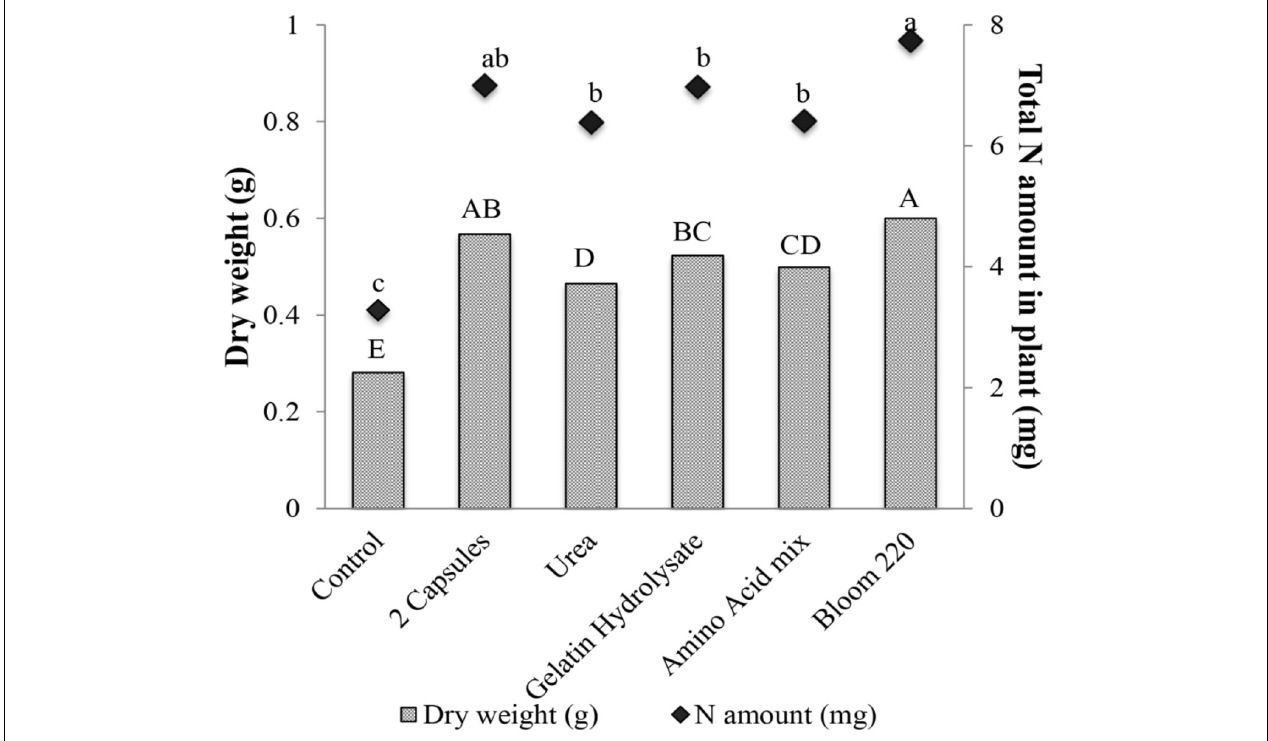
FIGURE 7 | Mean dry weight (g) and total nitrogen amount in plant (mg), 28 days after emergence of cucumber with six treatments: control, two gelatin capsule (2 Capsules), urea, gelatin hydrolysate, amino acid mixture (Amino acid mix), and bloom 220 gelatin (Bloom 220). Data analyzed by ANOVA ( α = 0.05) and Tukey’s HSD test was used to conduct mean separation. Letters (Capital letters for dry weight and small letters for N amount) not associated with same letter are significantly